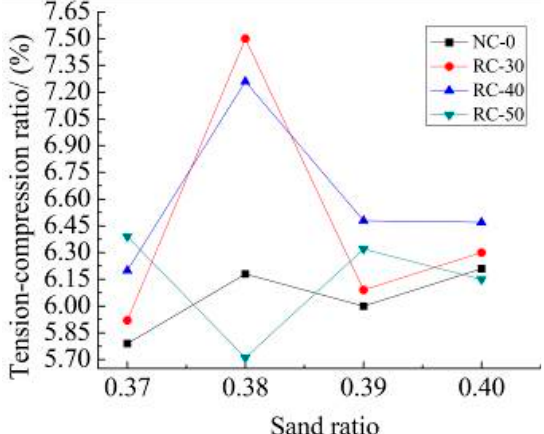
Figure 10. Tension and compression ratio.